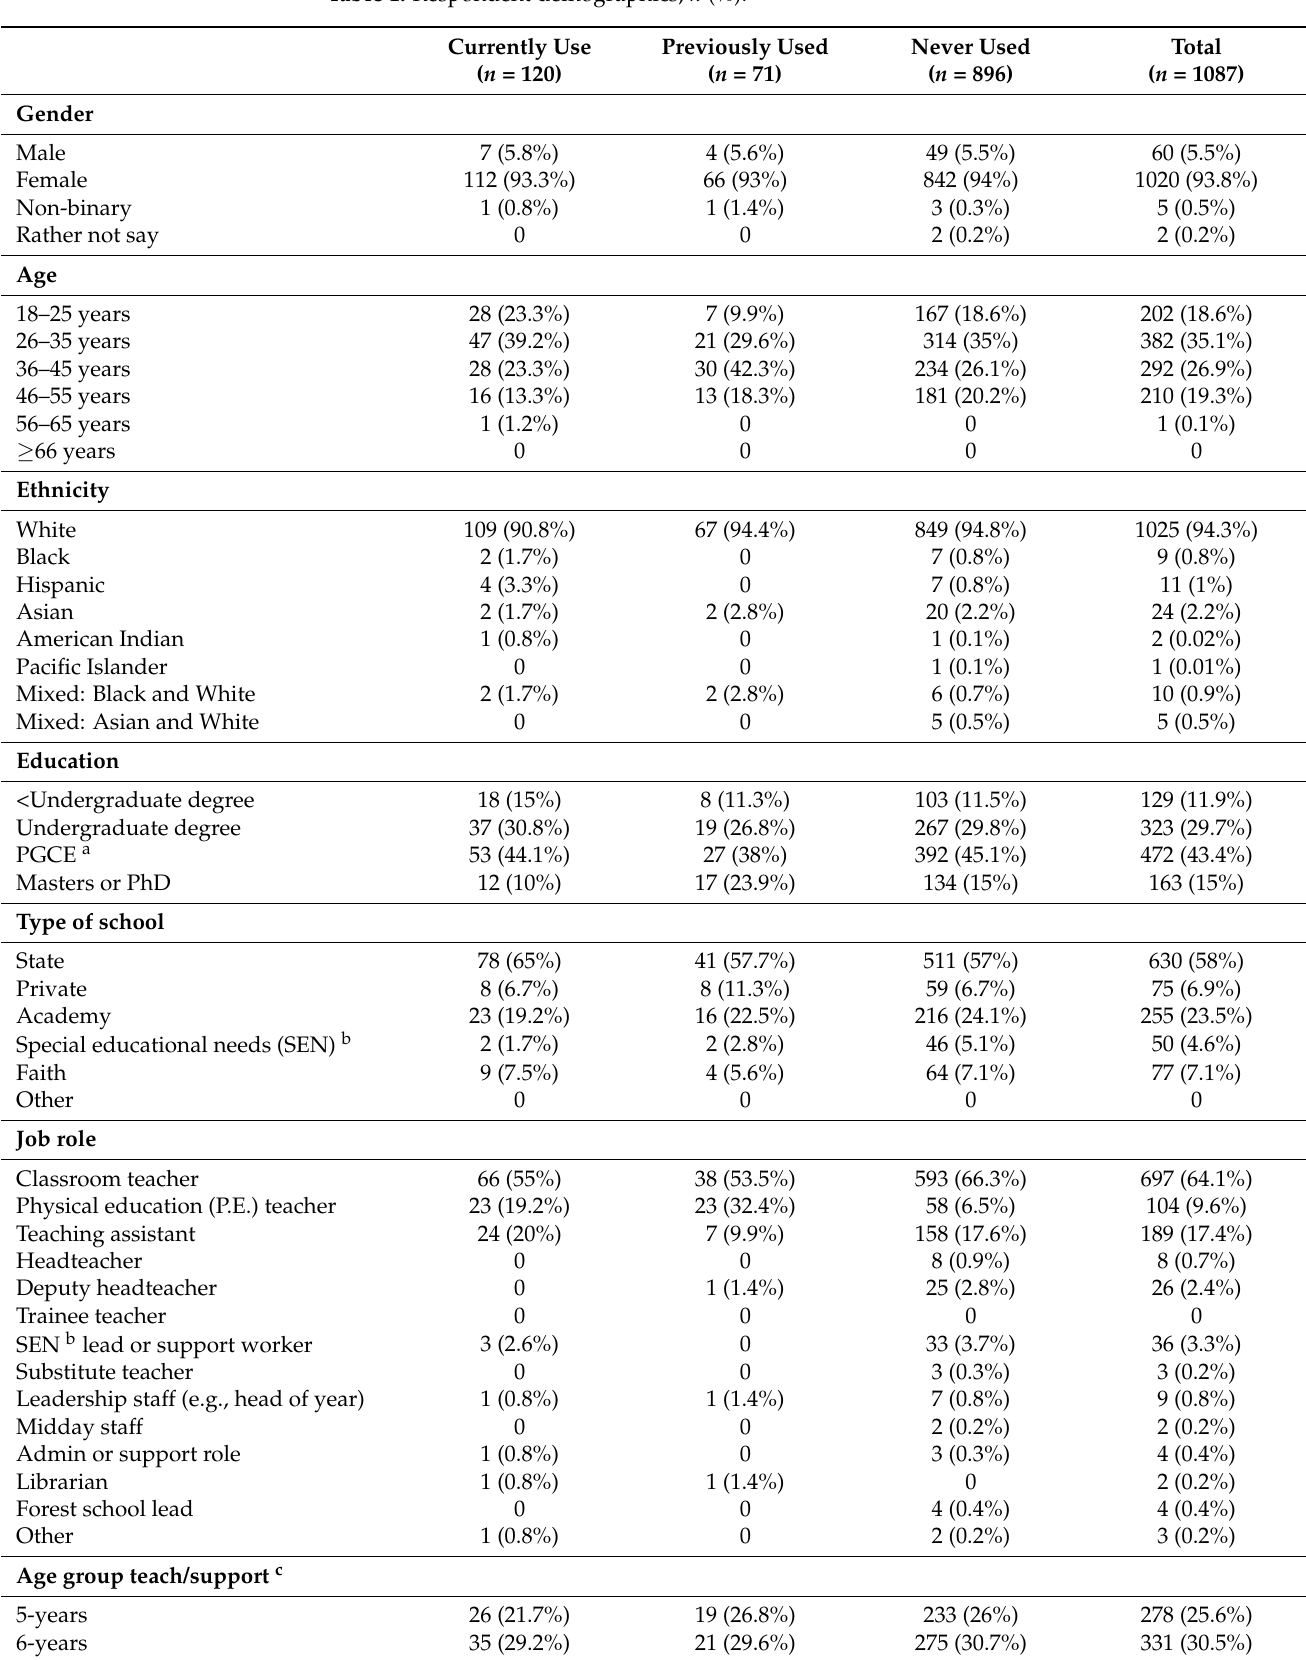
Table 1. Respondent demographics, n